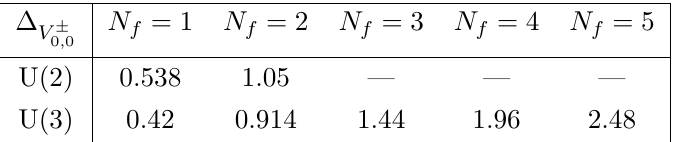
of the double adjoint theory without 0 , 0 3 are absent because Tr X 4 f ≥